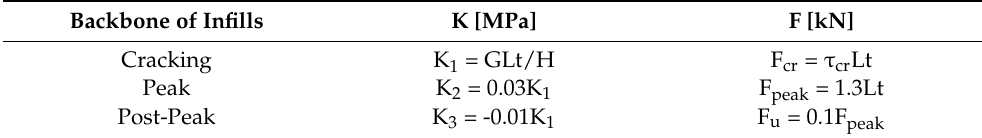
Table 8. Infill’s backbone critical